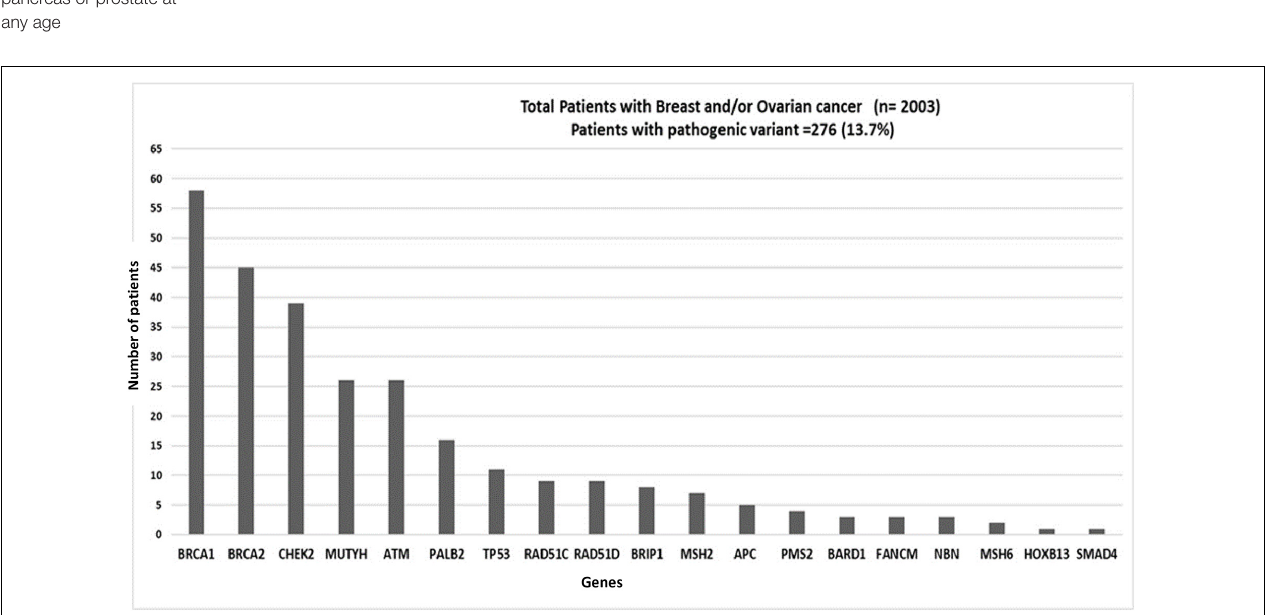
FIGURE 3 | Graph showing distribution of pathogenic variants (PVs) in patients with breast and/or ovarian cancer: Patients presenting with Breast and/or Ovarian cancer ( n = 2003). 13.7% (276/2003) patients tested positive for a PV. Genes with PVs are listed on the X -axis; Number of patients positive for a pathogenic variant is shown on Y -axis.